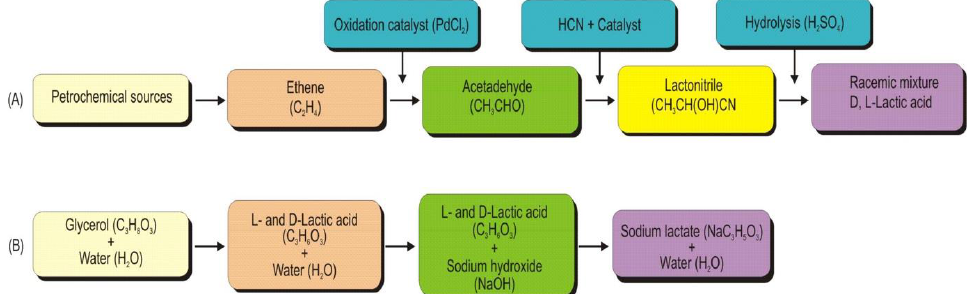
Figure 3. Block diagram of chemical synthesis of lactic acid using sources and conditions. ( A ): Synthesis of lactic acid using petrochemical source and ( B ): Alkaline hydrothermal conversion of glycerol to lactic acid and its lactate (Adapted from Yankov (2022) [24]). Alkaline hydrothermal conversion of glycerol yielded chemical synthesis of a race- mic mixture of L- and D-lactic acid [25,26]. Zhou et al. (2010) [27] have shown that lactic acid could also be synthesized from mannitol (C6polyol) through alkaline hydrothermal conditions; however, the lactic acid yield from mannitol was lower than the yield obtained from glucose and glycerine. Other routes of chemical synthesis of lactic acid include oxi- dation of propylene glycol at a low temperature [28], conversion of propene into α -nitro- propionic acid using nitric acid in the presence of oxygen, and α -nitropropionic acid is then hydrolyzed into lactic acid [22].